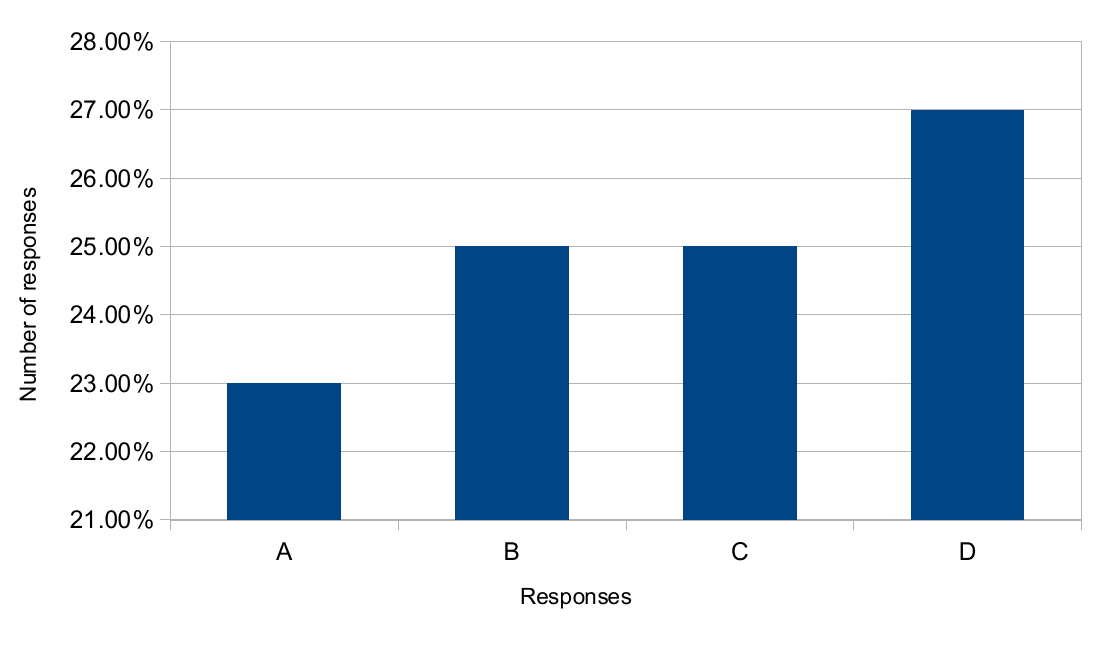
Figure 4. The definition of dyslexia A: Dyslexia is a specific difficulty in reading and writing of children with normal intellectual development B: Dyslexia is a specific difficulty in reading and writing and abnormalities of small and large motor activity of children and the abnormal intellectual development C: Dyslexia is a specific difficulty in reading and writing and abnormalities of small and large motor activity of children with normal intellectual